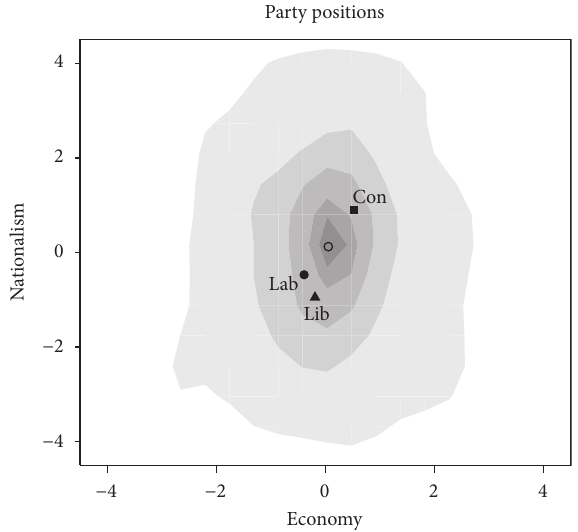
Figure 4: Electoral distribution and estimated party positions in Britain in 2005.